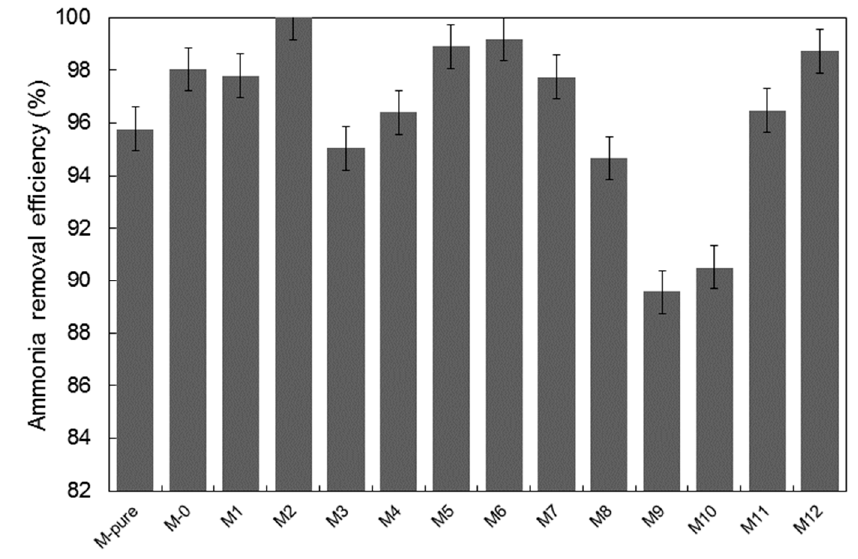
Figure 8. Removal efficiency of ammonium nitrogen of membranes synthesized.